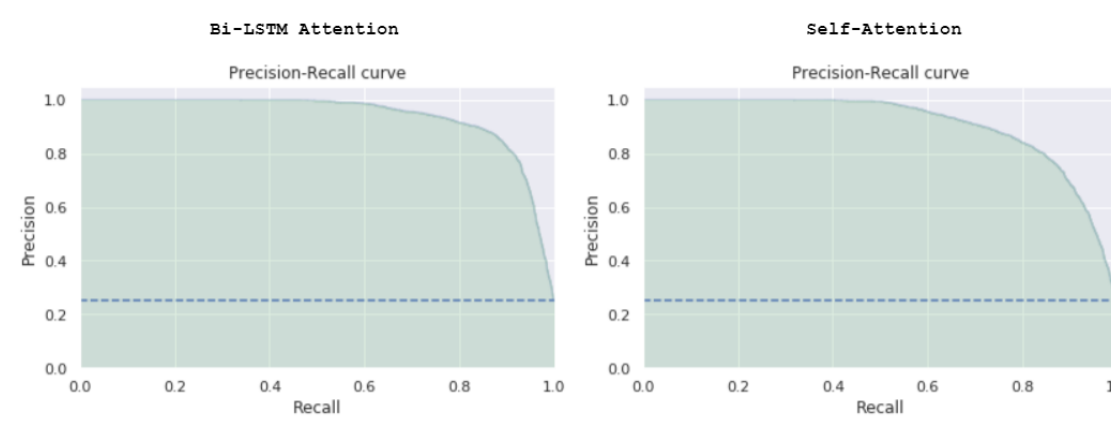
Figure 7. Area under PR-Curve with Bi-LSTM Attention (Left) and Self-Attention